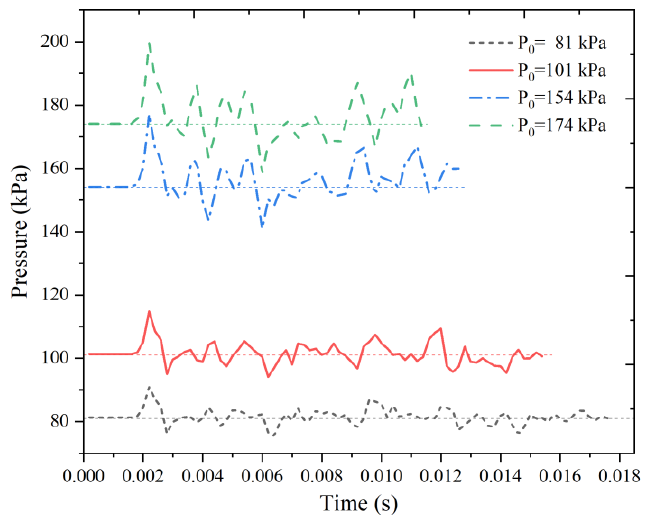
Figure 9. Results of the measured pressure at x = 0.7 m under different initial pressures.